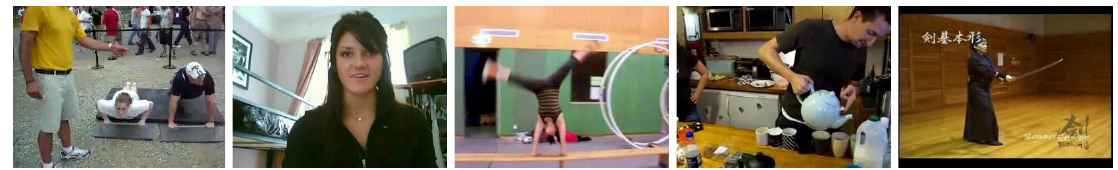
Figure 3. HMDB51 dataset from left to right Push-up, Chew, Cartwheel, Pour, Sword-Exercise.